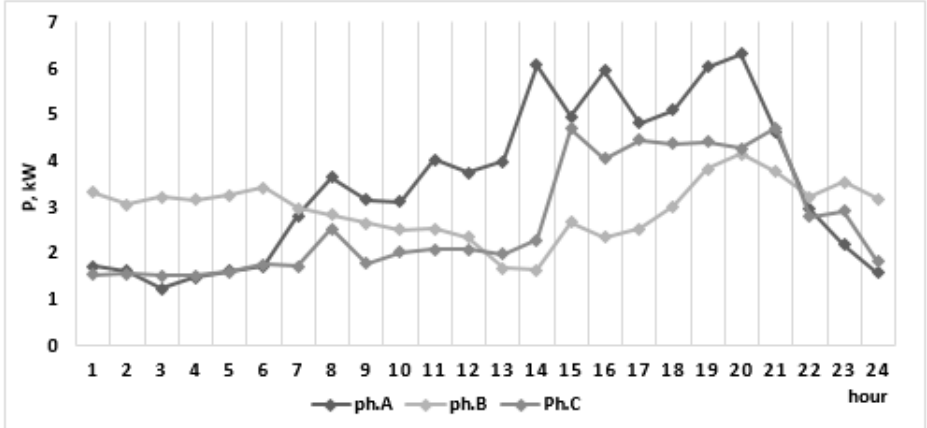
Figure 6. The hourly consumption in the network.